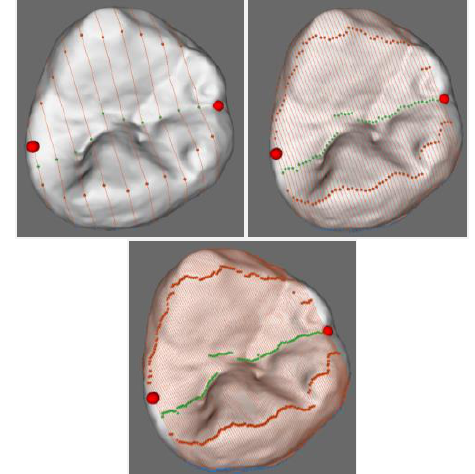
Figure 10. Progressive stages of single direction